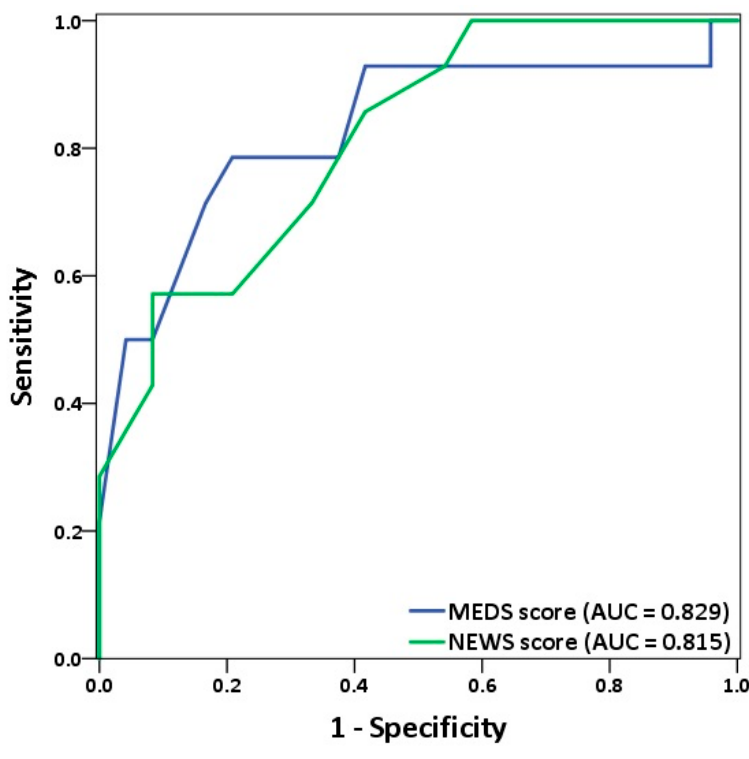
Figure 3. ROC of both MEDS and NEWS analyzed to show the accuracy in predicting mortality risks of LM bacteremia. The AUC of ROC for MEDS and NEWS indicated 0.829 and 0.815, respectively. AUC = Area under the curve; ROC = Receiver operating characteristic curve.